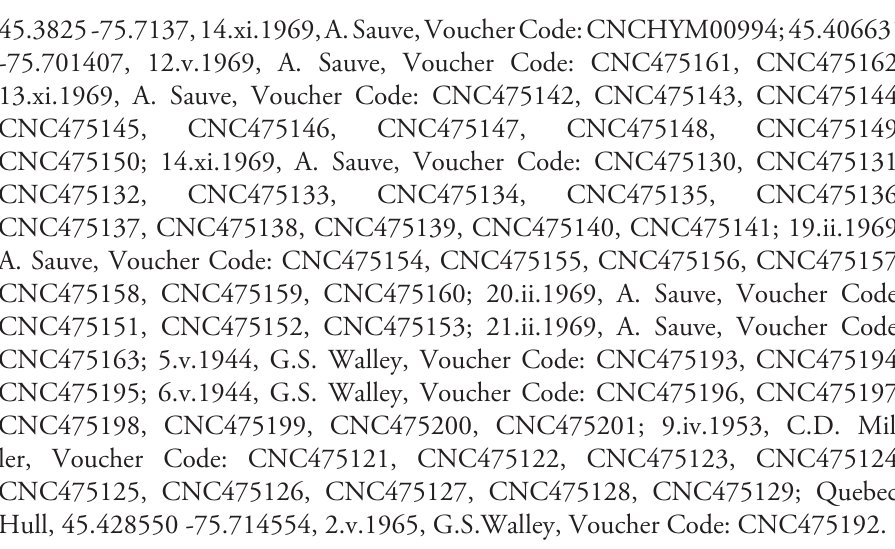
Fig. 21 Distribution. NEA.